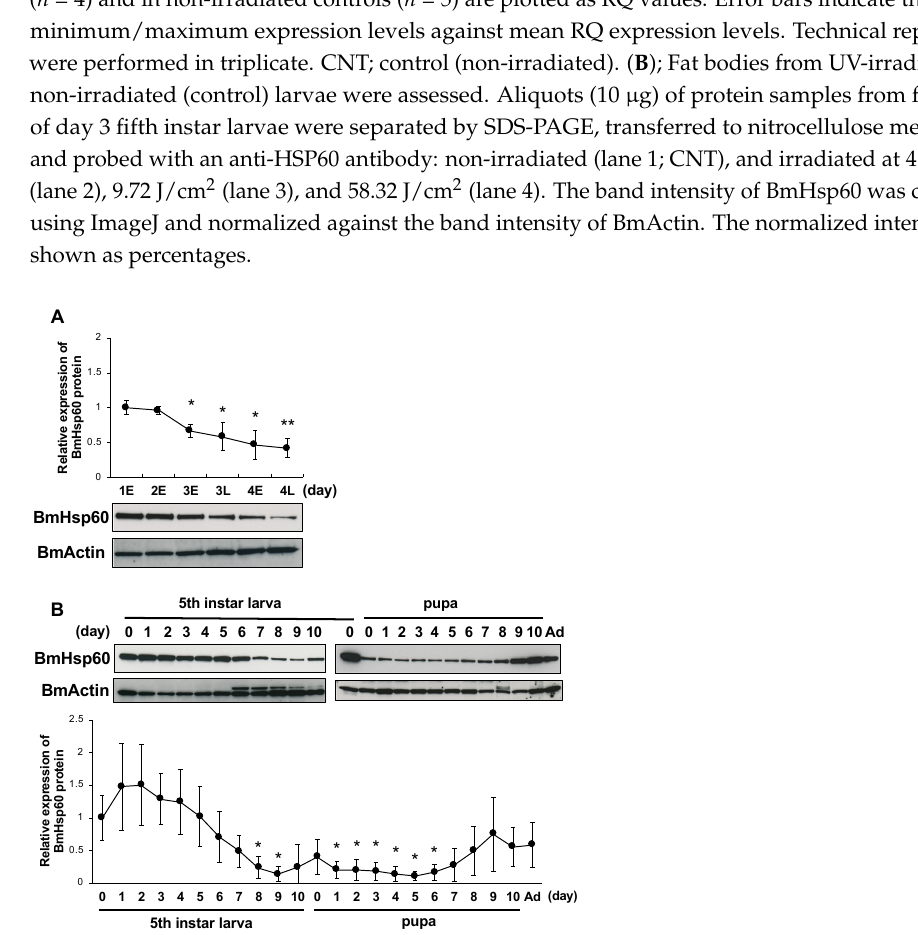
Figure 4. BmHsp60 protein expression during development in the fat body. ( A ); Expression of BmHsp60 in the fat body from day 1 (fourth instar larvae) to day 4 (fourth instar larvae). Aliquots (10 µ g) of the fat body lysate were separated by 15% SDS-PAGE, transferred to nitrocellulose mem- branes, and probed with the anti-HSP60 antibody. BmActin was used as an endogenous control. Expression was quantified at 0 h on day 1 (fourth instar) (day 1E), 0 h on day 2 (fourth instar) (day 2E), 0 h on day 3 (fourth instar) (day 3E), 12 h on day 3 (fourth instar) (day 3L), 0 h on day 4 (fourth instar) (day 4E), and 12 h on day 4 (fourth instar) (day 4L). The relative expression levels were calculated